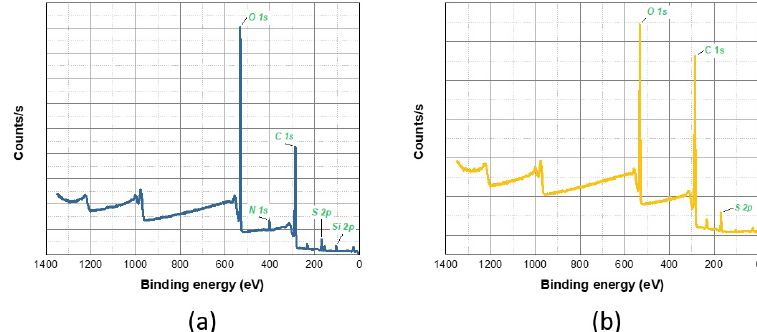
Figure 5. XPS spectra for GO-2 (a) and GO-4 (b) samples: survey scan.